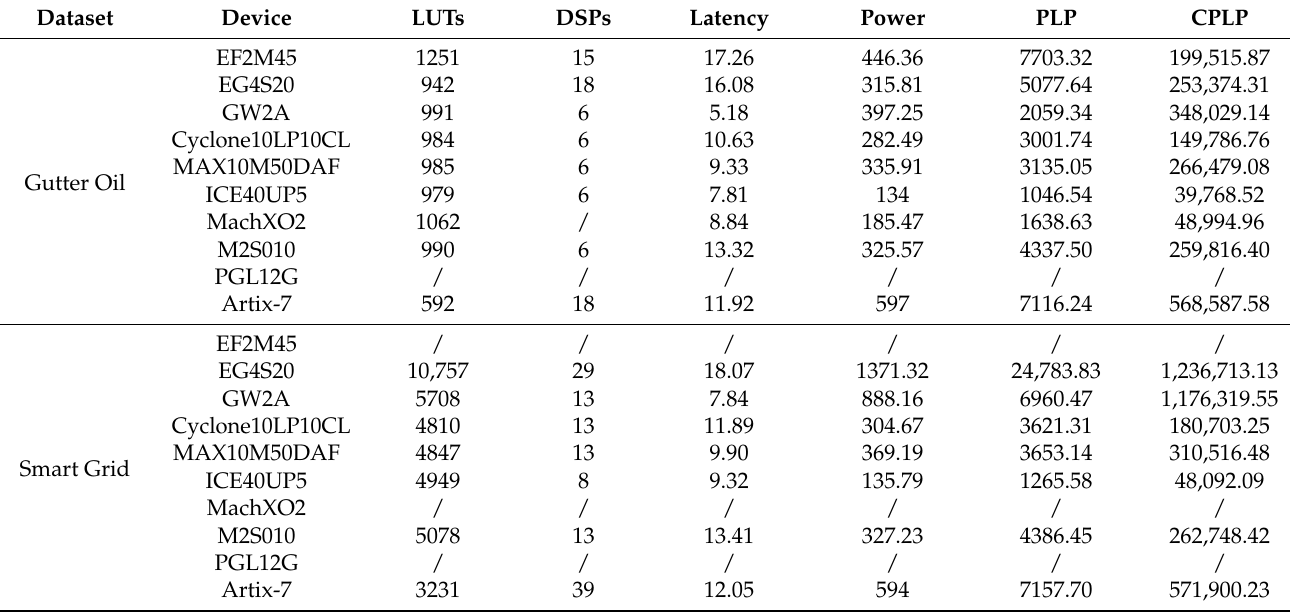
Table A6. The k-NN deployment results on the low-cost